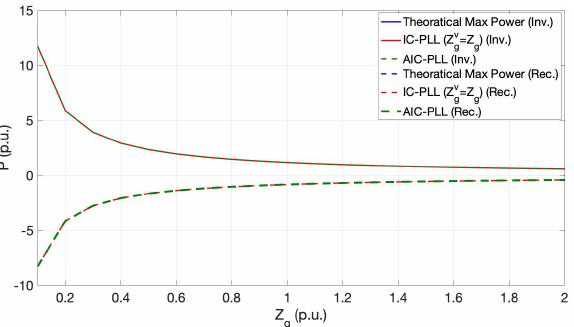
Figure 7. Steady-state power transfer stability limits of VSC-HVDC system for different types of